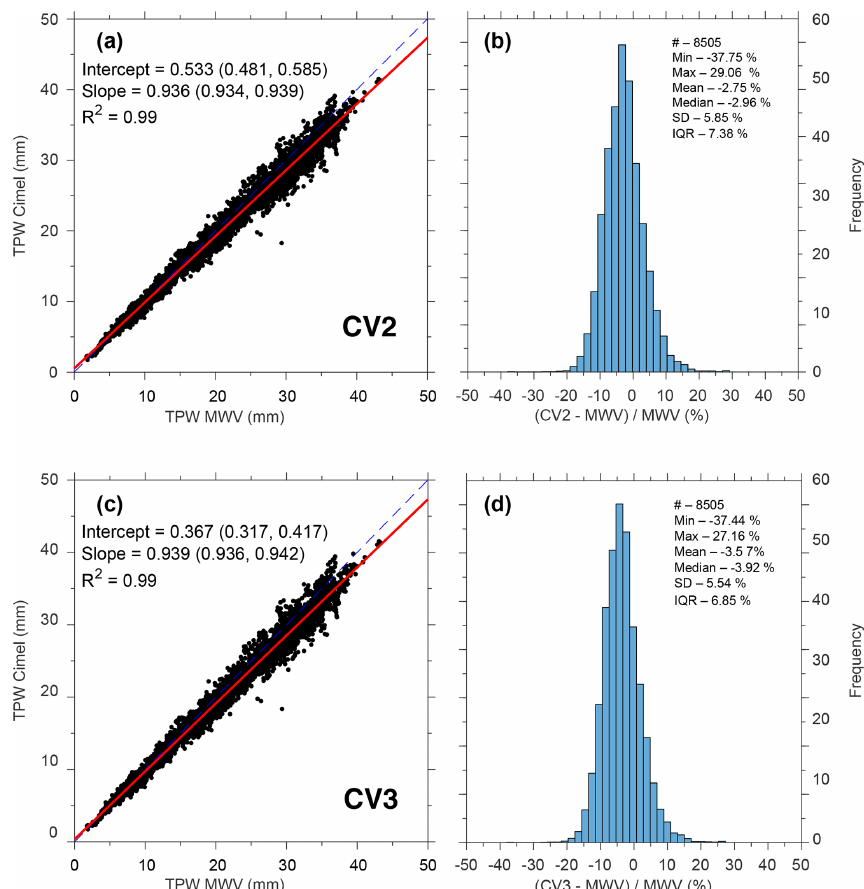
Figure 14. Scatter plot between the TPW from (a) the microwave radiometer and Cimel V2 and (c) Cimel V3. The red thick line shows the least-square regression line and the blue dashed line is the identity line. The regression coefficients are displayed along with their 95% confidence interval (in parentheses). Frequency histogram of the relative difference between (b) the TPW from the microwave radiometer and Cimel V2 and (d) Cimel V3,